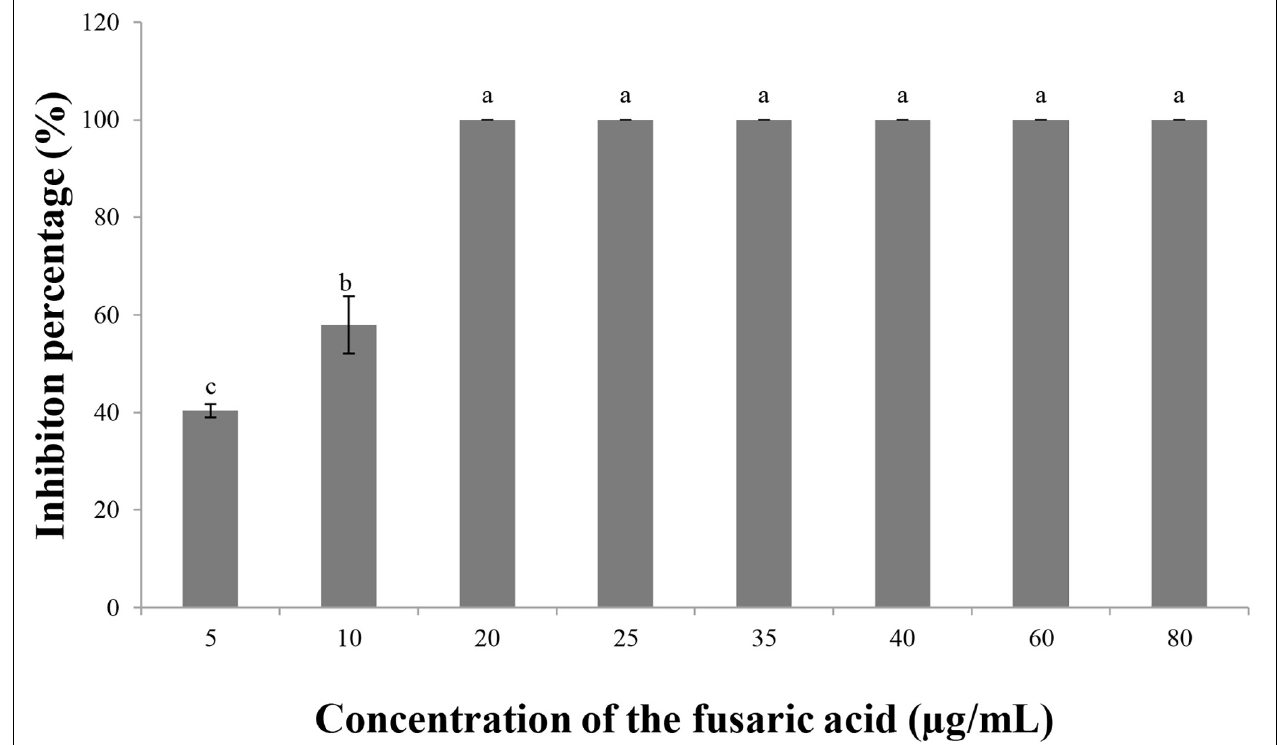
FIGURE 6 | Inhibitory effect of fusaric acid of different concentrations on V. dahliae.